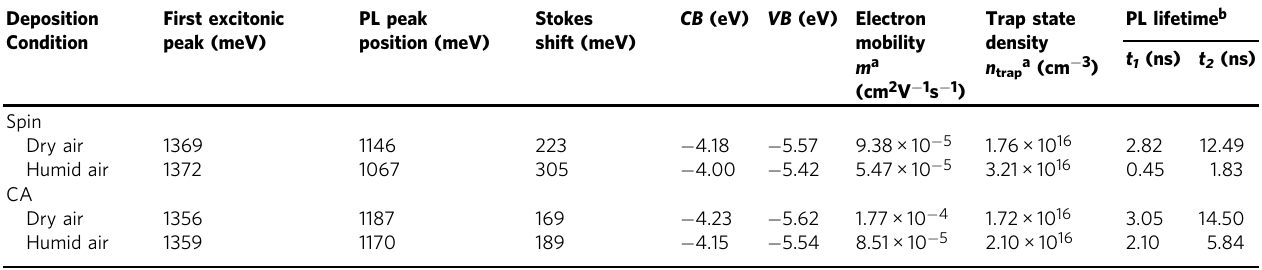
Table 1 Summarized photoelectric properties for the CQD solids prepared under different conditions. Deposition